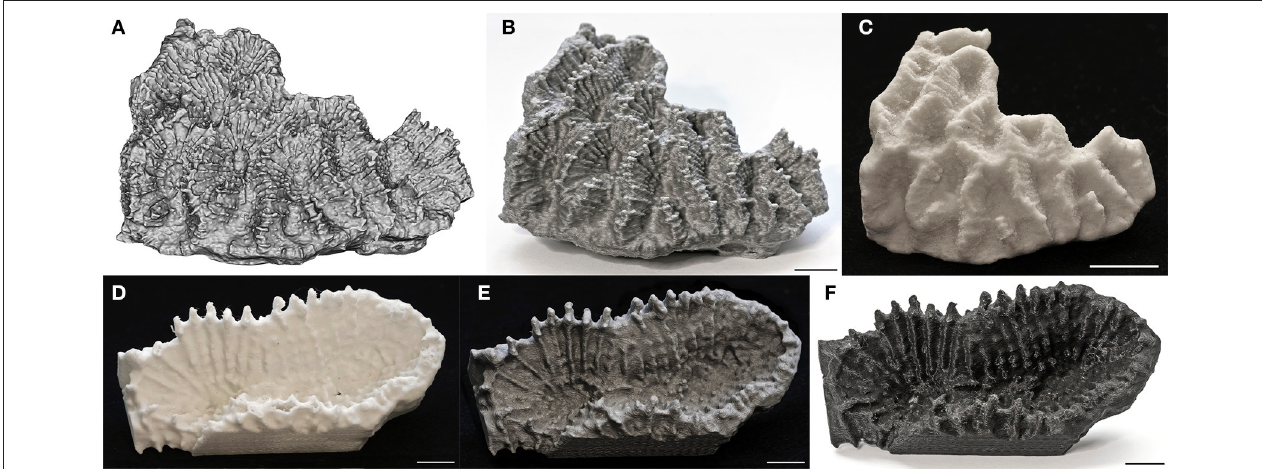
FIGURE 5 | Multi-material and multi-scale 3D printing of Oulophyllia crispa colony and corallites. (A) 3D digital model of colony sample using multi-image photogrammetry. (B) Silver PLA print of colony sample. (C) Sandstone print of colony sample. (D) White PLA print of corallites. (E) Silver PLA print of corallites. (F) Black PLA print of corallites. Scale bar represents